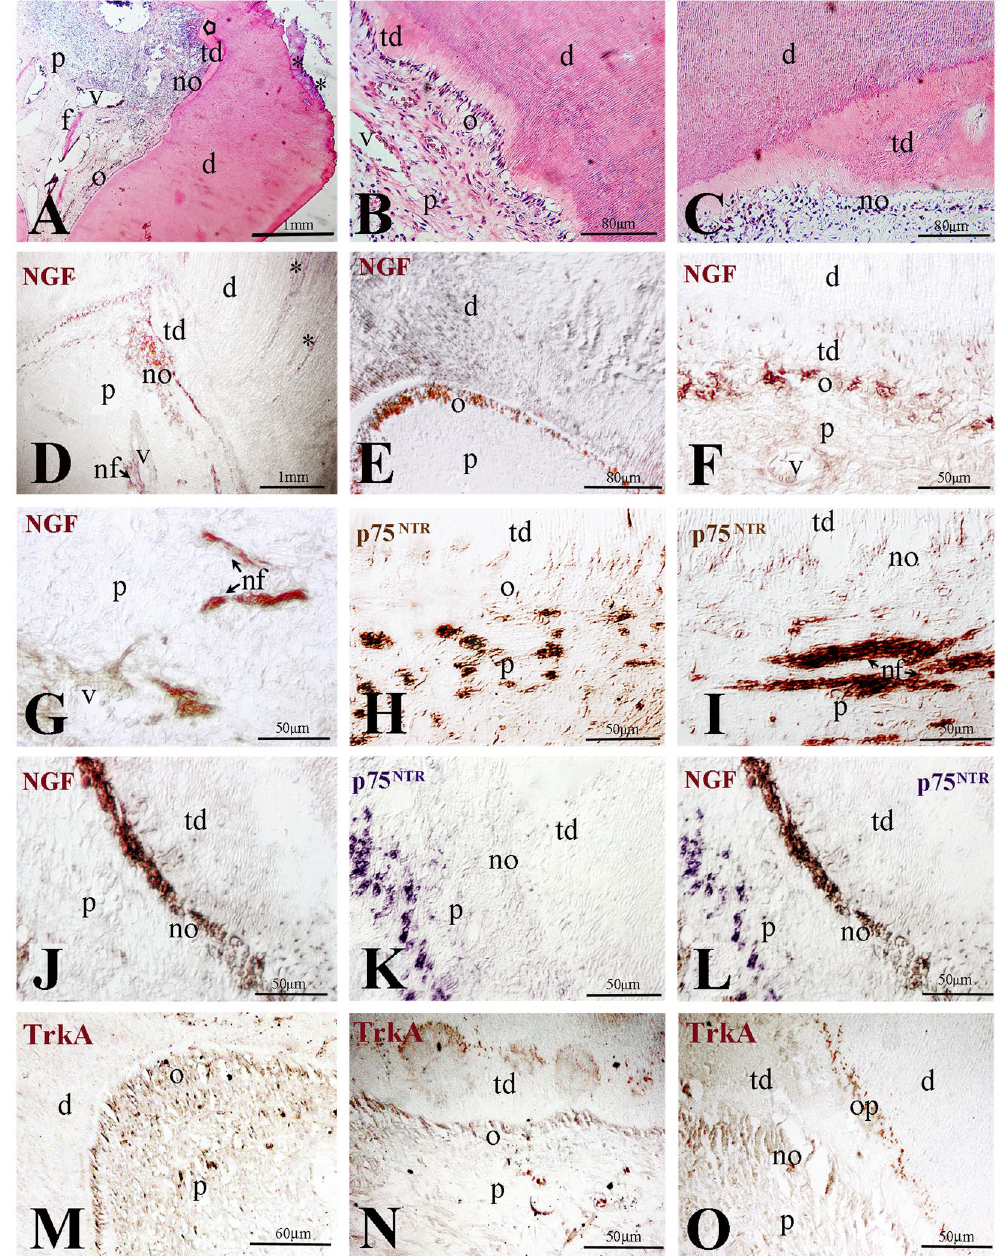
Figure 2. Expression of NGF, p75 NTR and TrkA in carious human teeth. ( A – C ) Histology of carious teeth. ( B , C ) higher magnifications of regions of production of tertiary dentine. ( D – F ) NGF expression (brown colour) in regions underlying the carious lesion ( D ), in proximity of the lesion ( E ), in odontoblasts producing tertiary dentine ( F ). ( G ) Expression of NGF in nerve fibres within the pulp. ( H , I ) p75 NTR expression (brown colour) in nerve fibres and vessels underlying newly formed odontoblasts. ( J – L ) Co-staining showing NGF (brown colour) and p75 NTR (violet colour) expression in the region underlying the carious lesion. ( M – O ) TrkA expression (brown colour) in odontoblasts facing the carious region ( M ) and in odontoblasts producing the tertiary dentin ( N , O ). Abbreviations: d, dentine; nf, nerve fibres; no, newly-formed odontoblasts; o, odontoblasts; op, odontoblast processes; p, pulp; td, tertiary dentine; v, vessel; Asterisks indicate the progression of the carious lesion in the